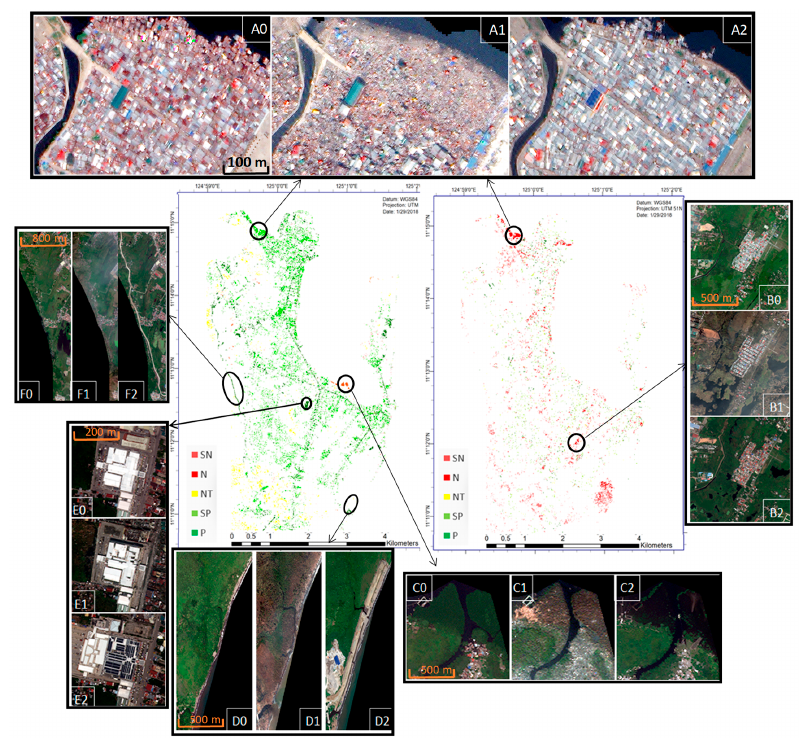
Figure 11. Visual examples of LC and LU-based recovery maps. ( A ) Two different recovery classes for the same area: Building-debris-building in the LC-based recovery map, and “IBA-debris-IBA” in the LU-based recovery map; ( B ) negative recovery at LU level (build back): “Crop/grass-inundated land/debris-crop/grass”; ( C ) negative recovery at LC level: “Tree-flattened tree-inland water”; ( D ) potential positive recovery that was not captured by the present recovery maps, highlighting the importance of the timing of imagery in RS-based recovery assessment; ( E ) positive recovery at the LC level: “Building / impervious surface-debris-building / impervious surface”; ( F ) positive recovery at the LC level: “Non-tree vegetation-non tree vegetation-impervious surface, a national road that was constructed 4 years after typhoon